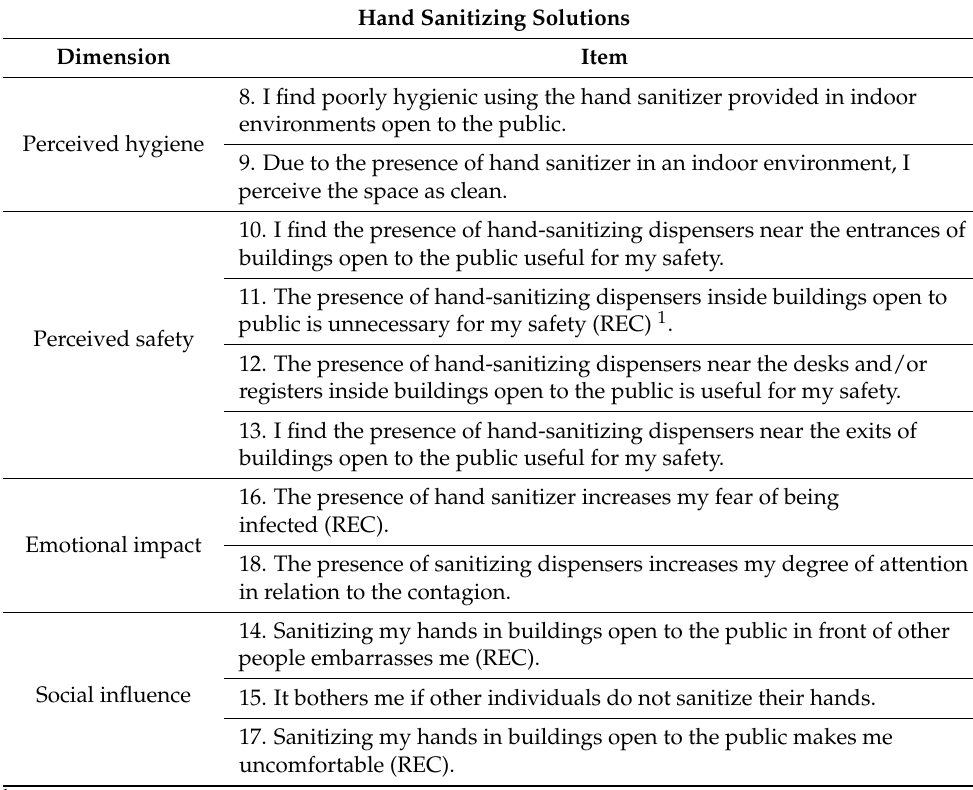
Table 2. Items examined for hand-sanitizing devices in the online survey and related dimensions. Own processing.